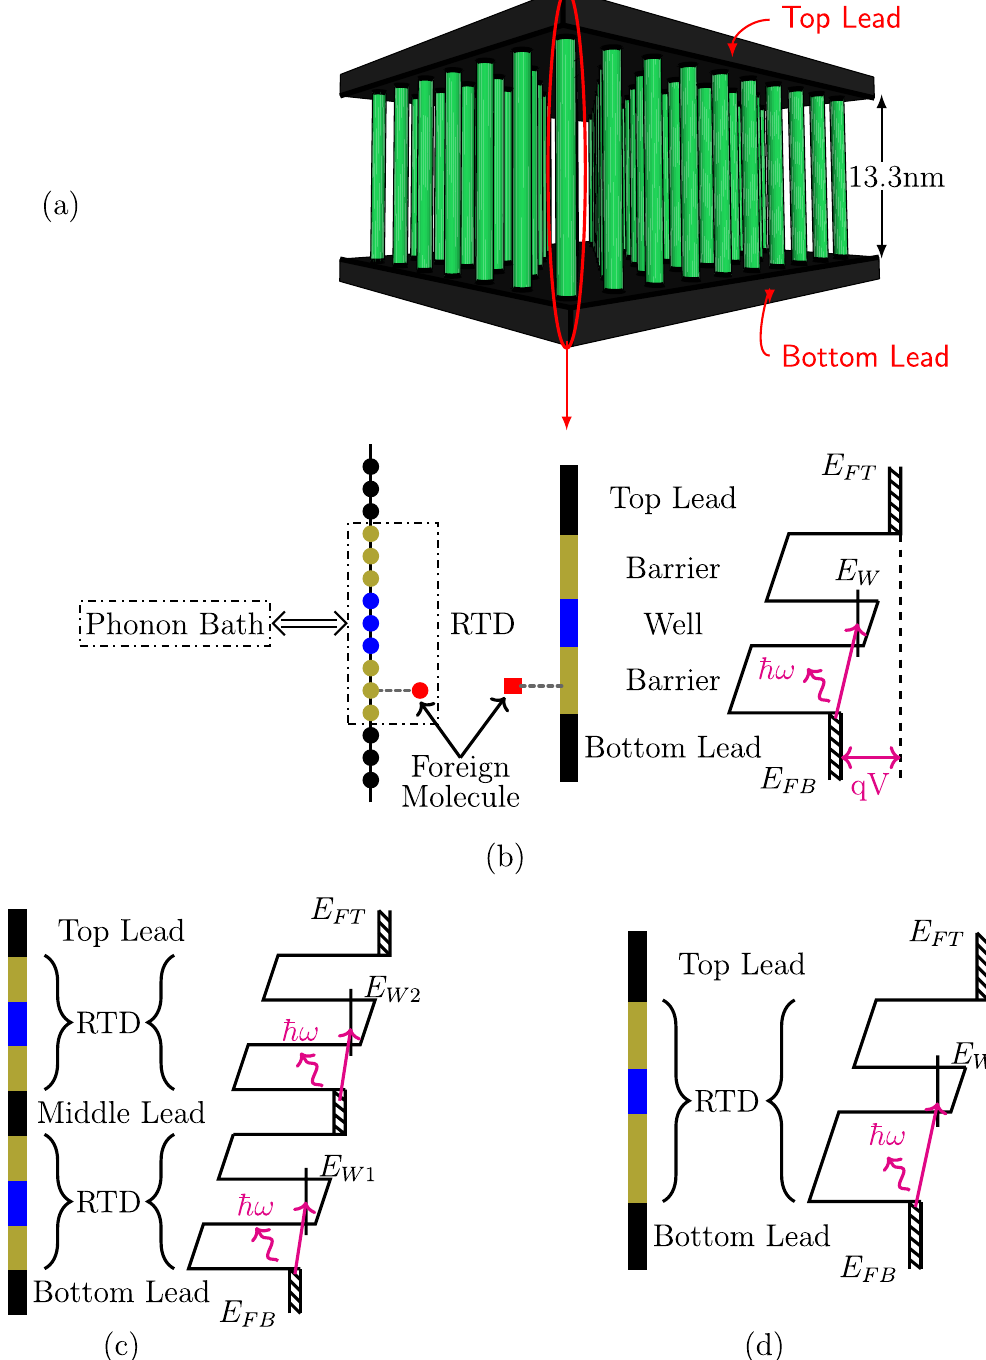
Figure 1. ( a ) 3D network of parallel nanowires. ( b ) From left to right - molecular arrangement, schematic structure, and band diagram (including illustration of phonon-assisted tunneling) for RTD nanowire. ( c ) From left to right - nanowire with symmetric RTDs connected in series, and corresponding band diagram. ( d ) From left to right - nanowire with asymmetric RTD, and corresponding band